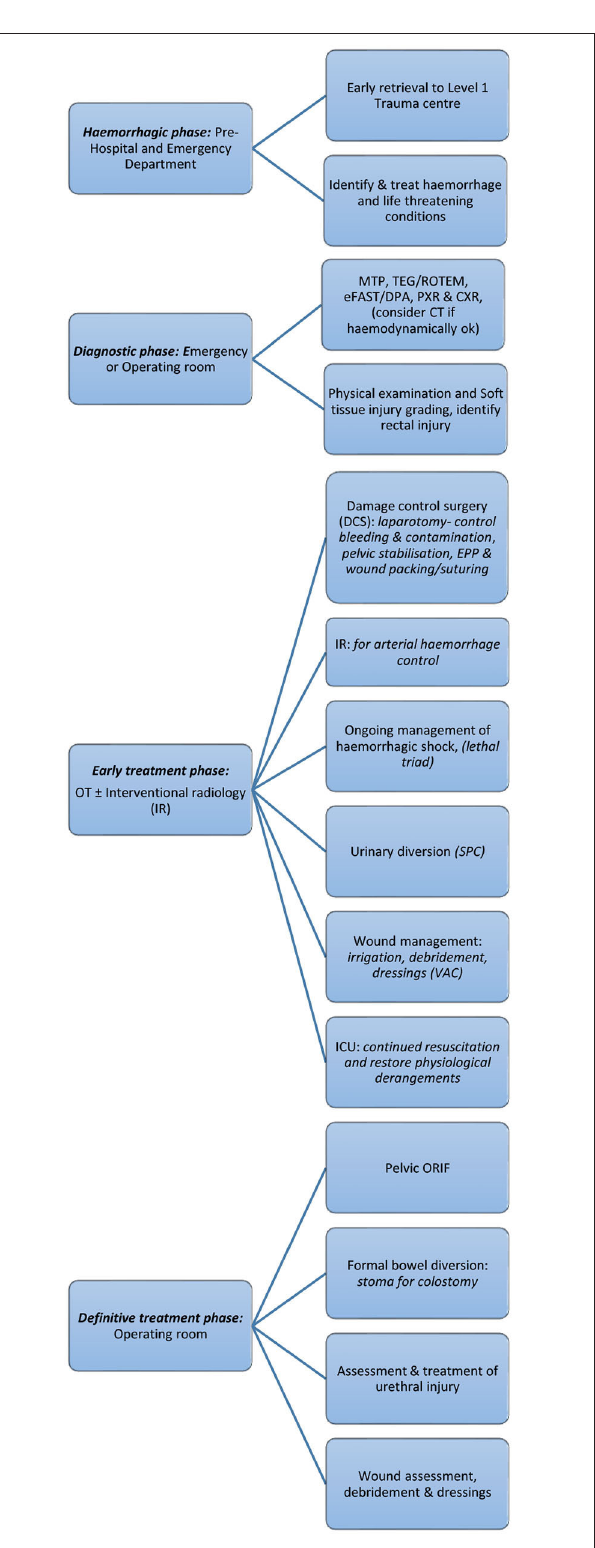
FIGURE 3 | Open pelvic fracture management algorithm